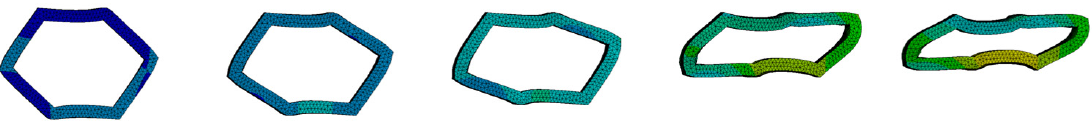
Figure 21. Experimental compression test of standard hexagonal cell under lateral load.